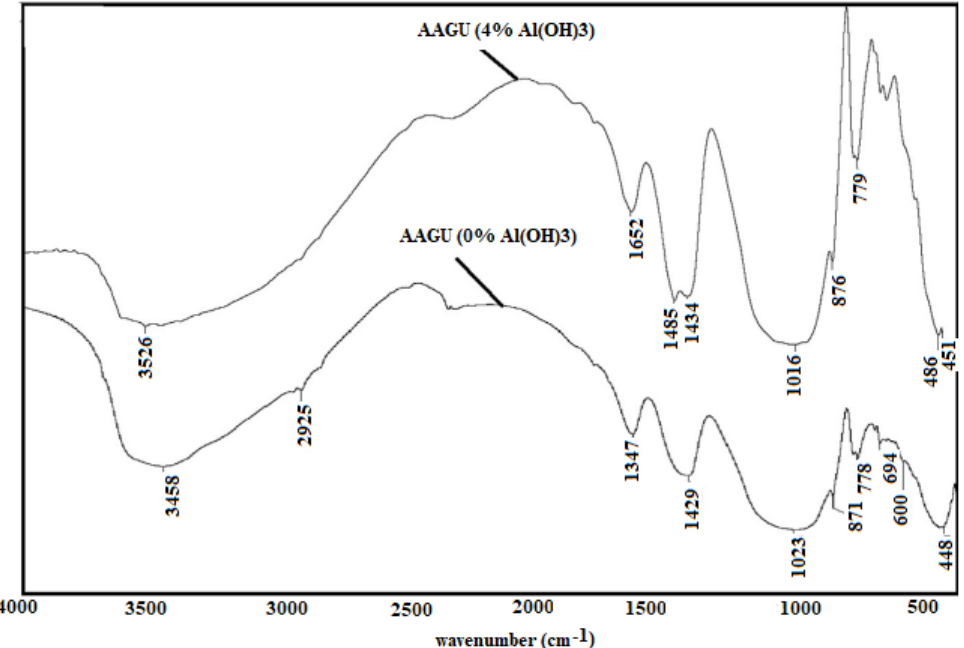
Figure 9. The effect of Al on Si-O-T band asymmetric stretching in an alkaline binder (From Elsevier Ref. [30] and used with permission).